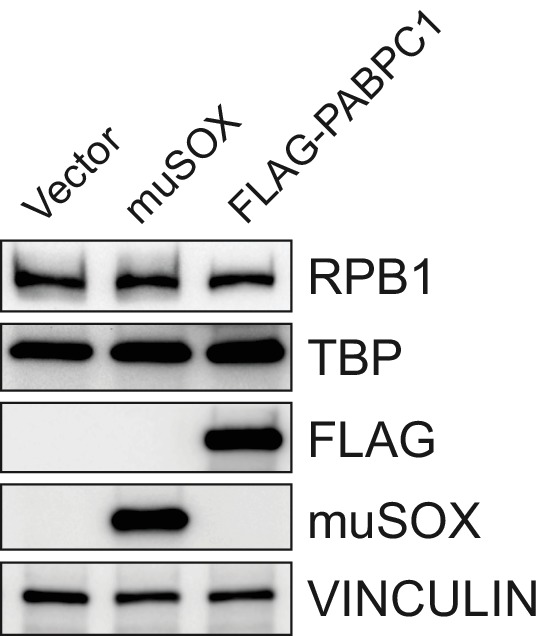
RNAPII Rpb1 and TBP protein levels are unchanged in cells expressing muSOX or FLAG-PABPC1.Western blot of cells expressing empty vector, muSOX, or FLAG-PABPC1, with VINCULIN serving as a loading control.